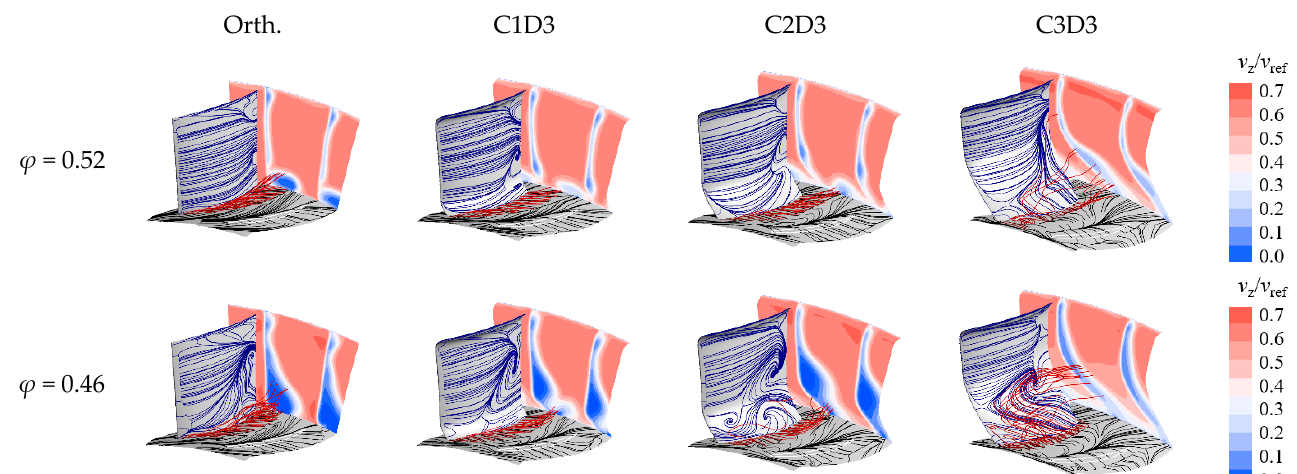
Figure 16. Flow field distribution for the cases with different dihedral heights.